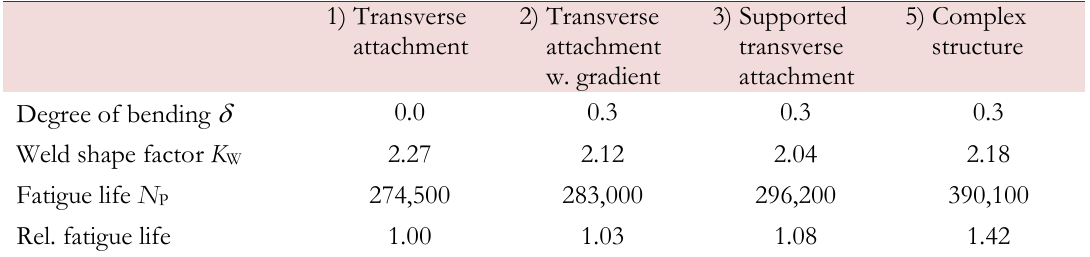
Table 5: Computed fatigue life N p for the same effective notch stress σ eff = 425 MPa at Detail C.